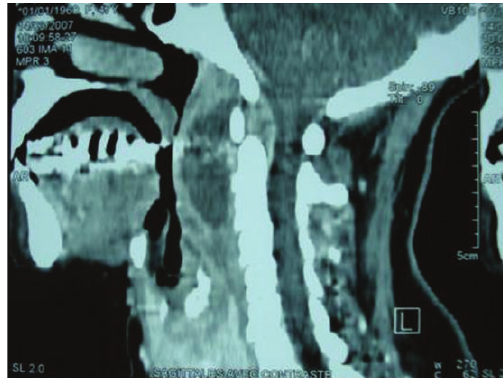
FIGURE 3: CT (sagittal view) showing retropharyngeal collection.